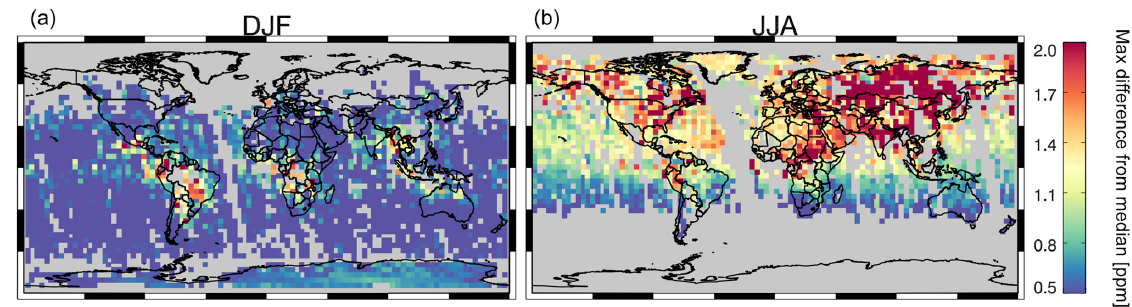
Figure 9. Maximum difference between each model and the model median in ppm, averaged over 4 ◦ × 4 ◦ grid boxes. Two seasons are shown: DJF (a) and JJA (b) . Soundings for which all models are within 1.5ppm of the model median are retained in the model-based truth